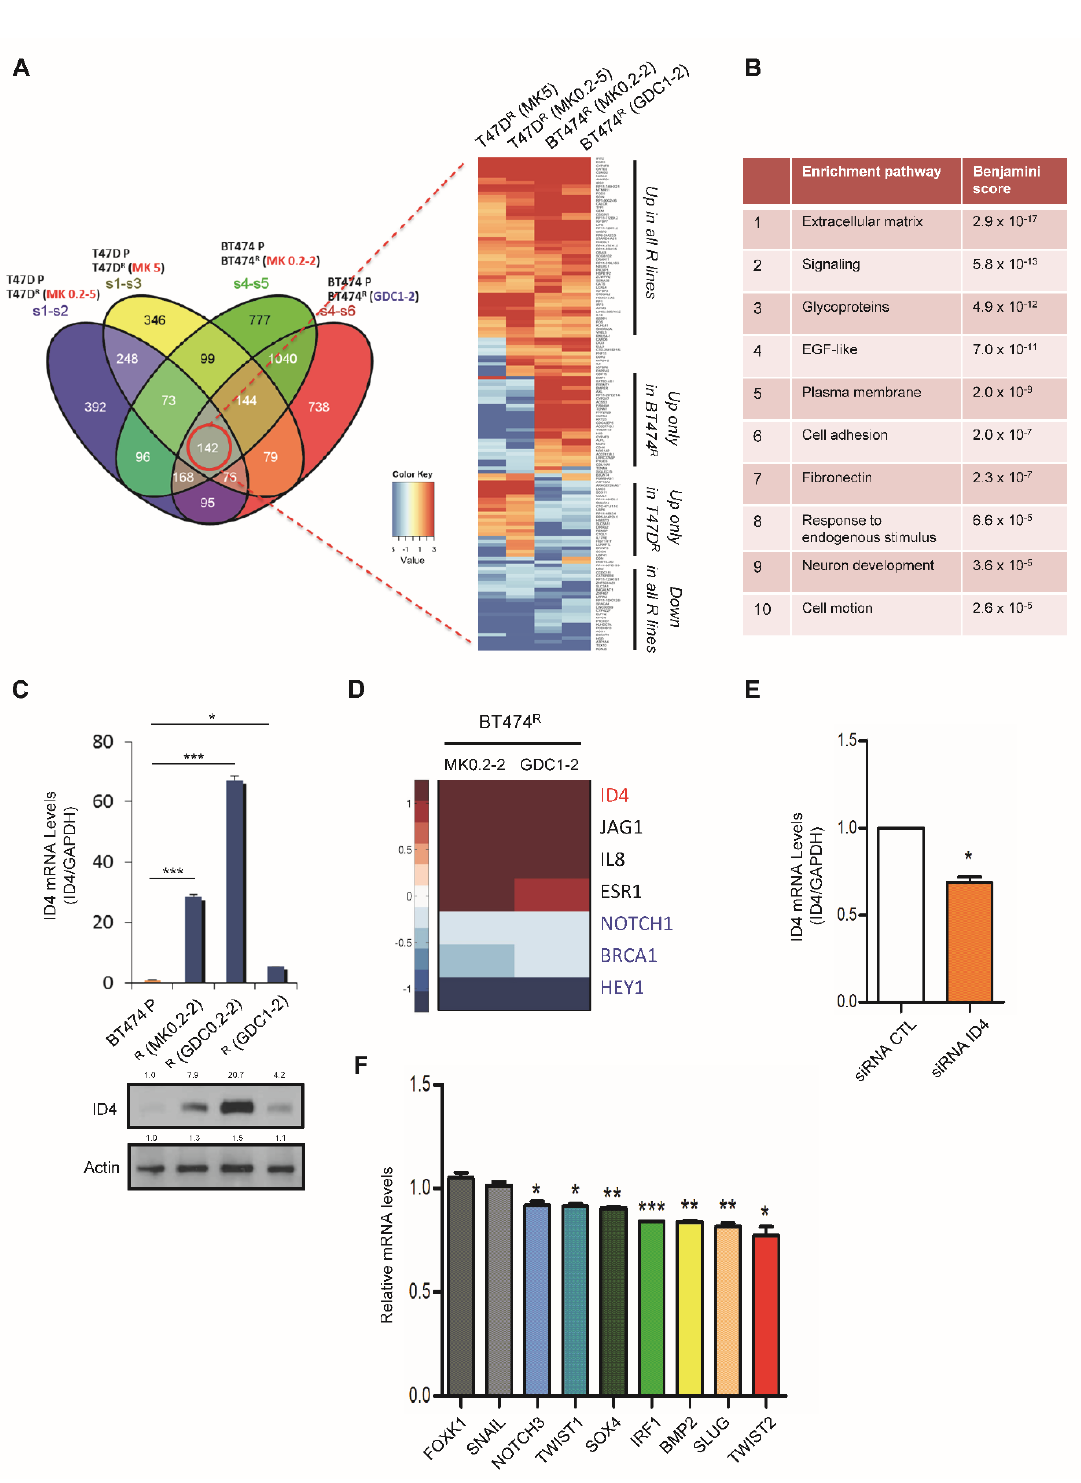
Figure 4. RNA sequencing reveals upregulation of ID4 in Akt-inhibitor-resistant cells. ( A ) Left: Venn diagram of distribution of differentially expressed genes in resistant lines. S1, T47D parental. S2, T47D MK0.2-5. S3, T47D MK5. S4, BT474 parental. S5, BT474 MK0.2-2. S6, BT474 GDC1-2. Right: Heatmap displaying genes (142) in which expression is changed (logFC > 1 or logFC < − 1) across all comparisons; logFC of these genes are plotted in the heatmap. ( B ) Gene set enrichment analysis showing the top 10 enrichment pathways in T47D resistant cells. ( C ) Upregulation of ID4 in BT474 resistant cells at the mRNA (top) and protein (bottom) levels. Error bars, mean ± SEM: *, p < 0.05; ***, p < 0.001 (ANOVA, n = 3). ( D ). Heatmap showing alteration of ID4 pathway gene expression in the